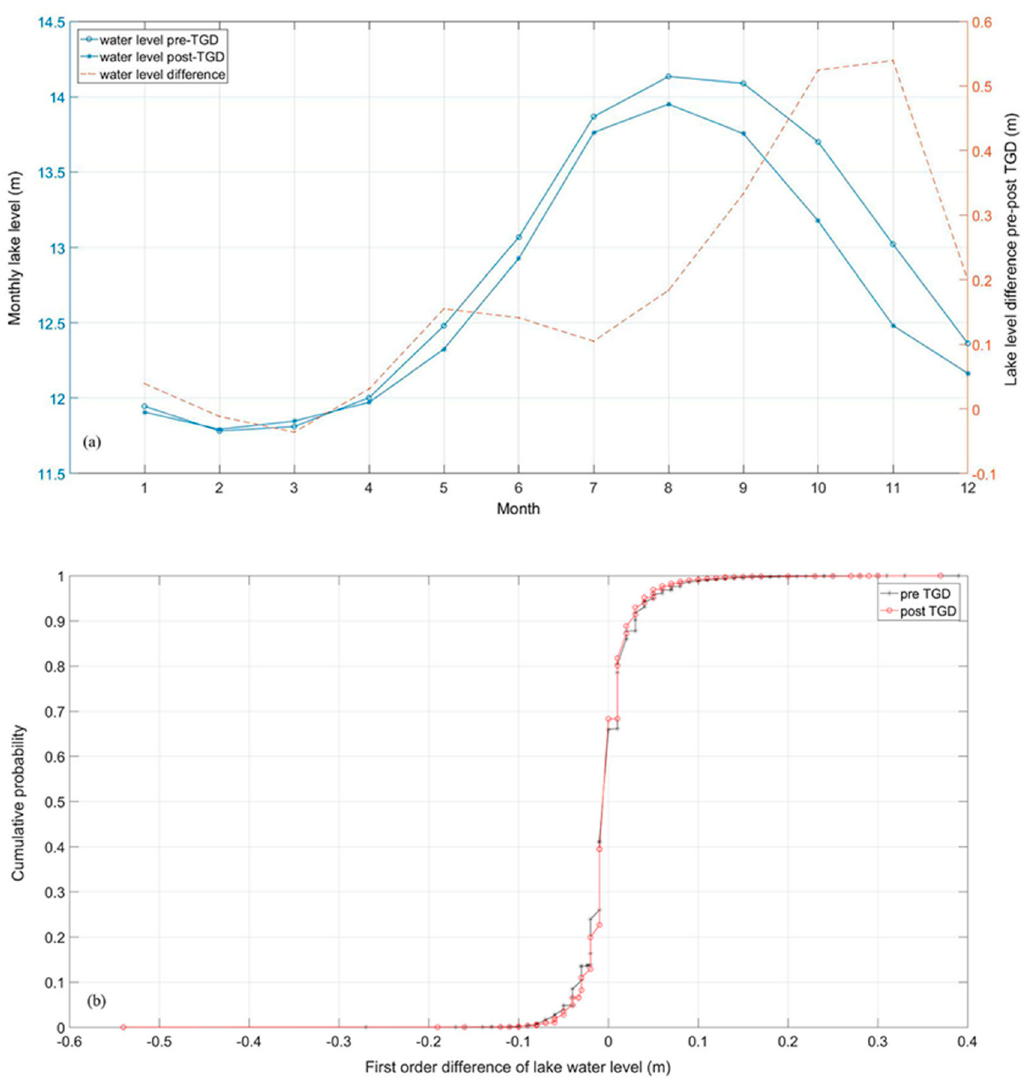
Figure 6. ( a ) Impacts of Three Gorges Dam (TGD) regulation on monthly water level in Huayang Lakes; and ( b ) cumulative probability of first order difference of water level in Huayang Lakes.